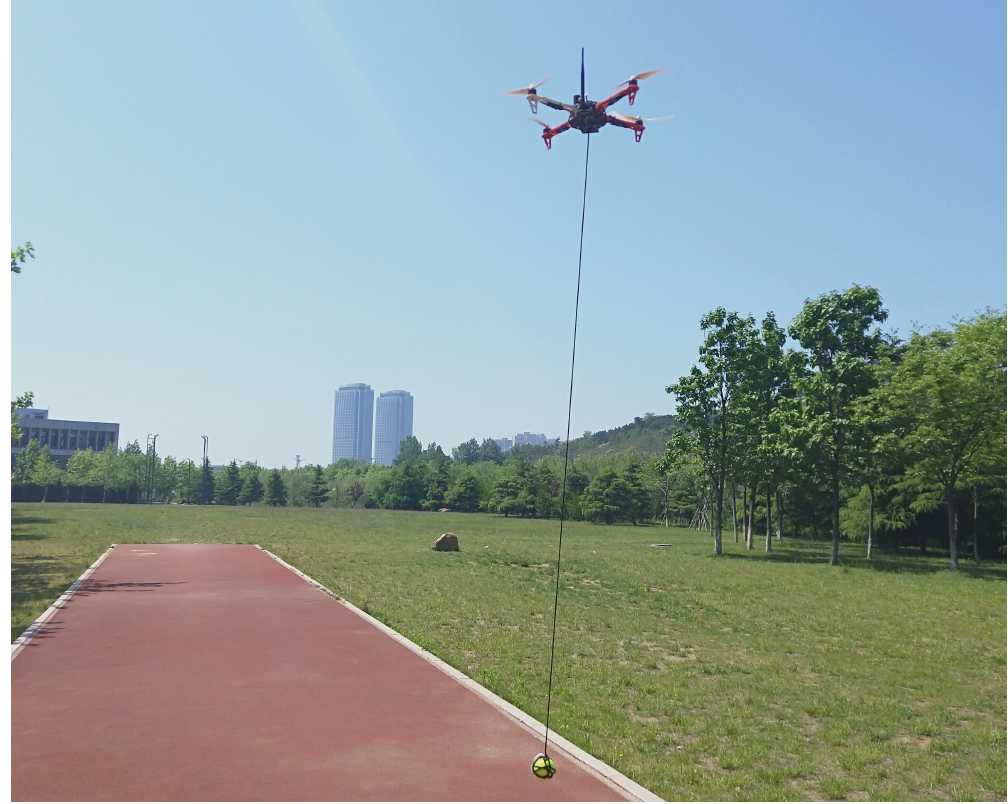
Figure 8. The UAV transportation system following the pre-planned path in the outdoor